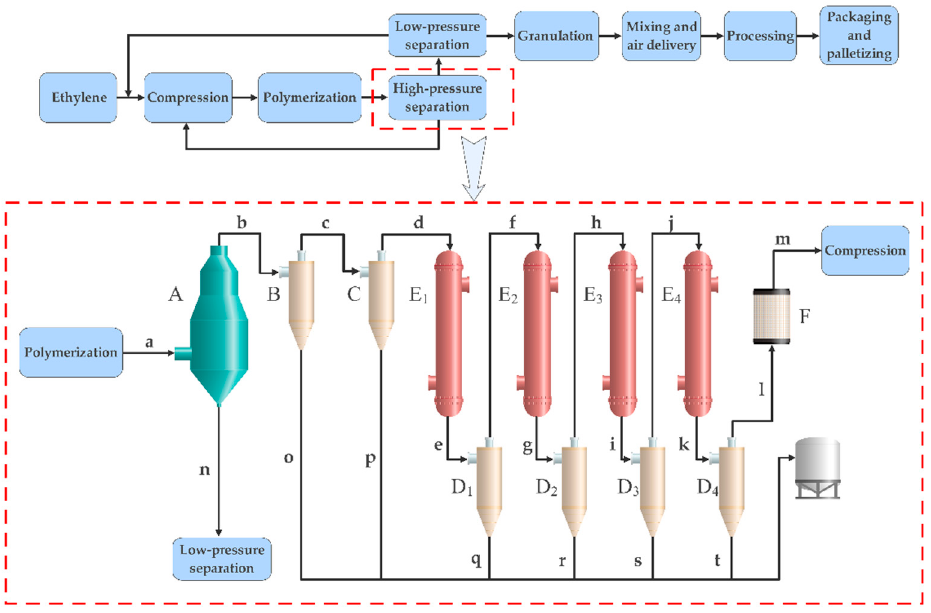
Figure 1. High-pressure polyethylene process flow and high-pressure separation system.